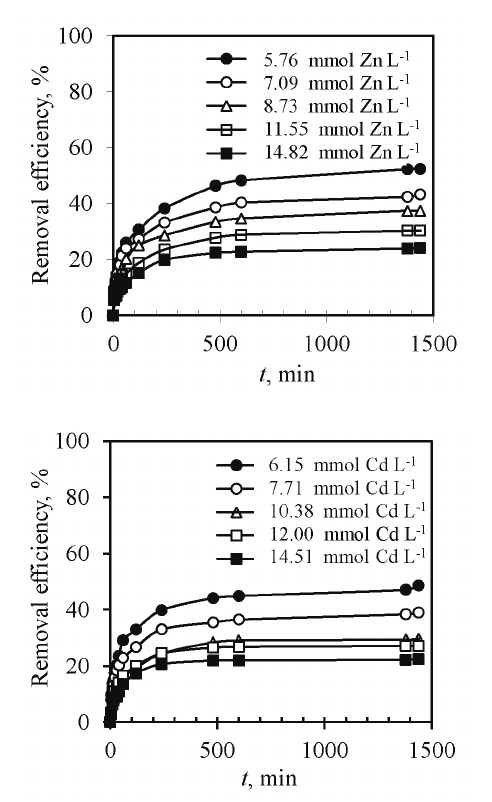
Fig. 3 – Removal efficiency of zinc and cadmium uptake per gram of IZM vs. time